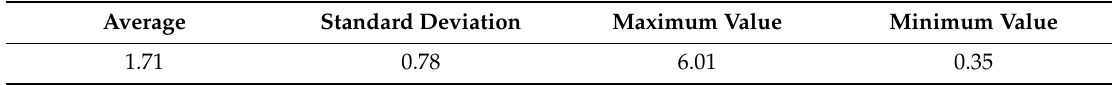
Figure 7. Frequency distribution of the parameter p values. Table 1. Statistics of the parameter